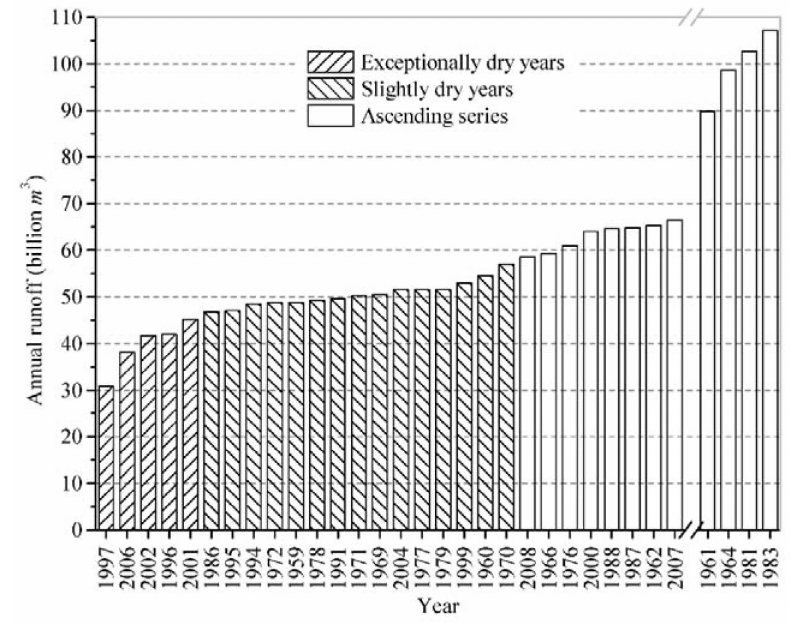
Figure 7. Annual runoff series in ascending rank